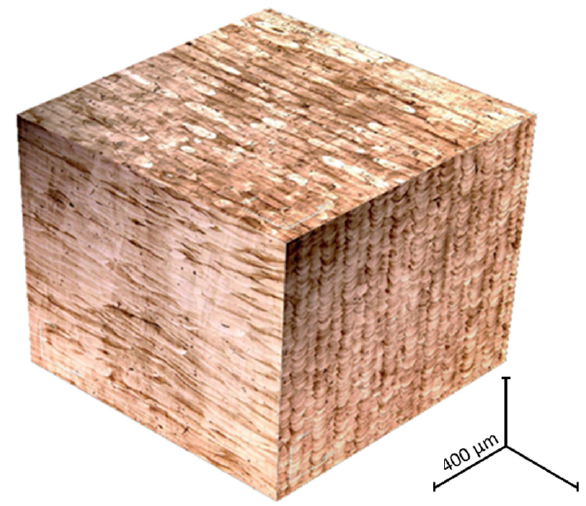
Figure 10. 3D metallograph of optimal specimen.